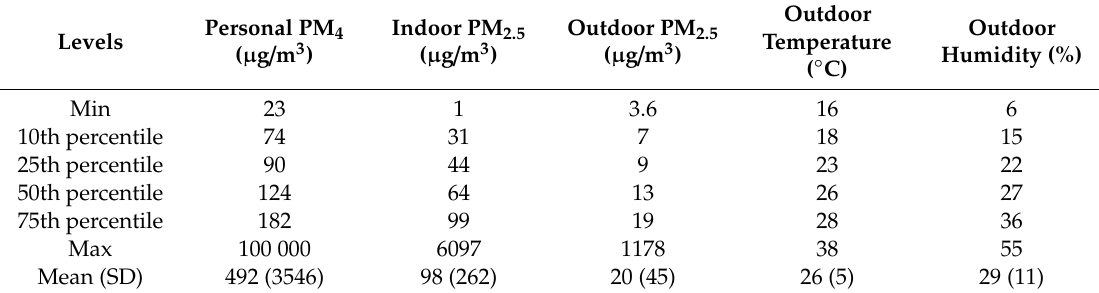
Table 2. Particulate matter (PM) measurements and meteorological data.